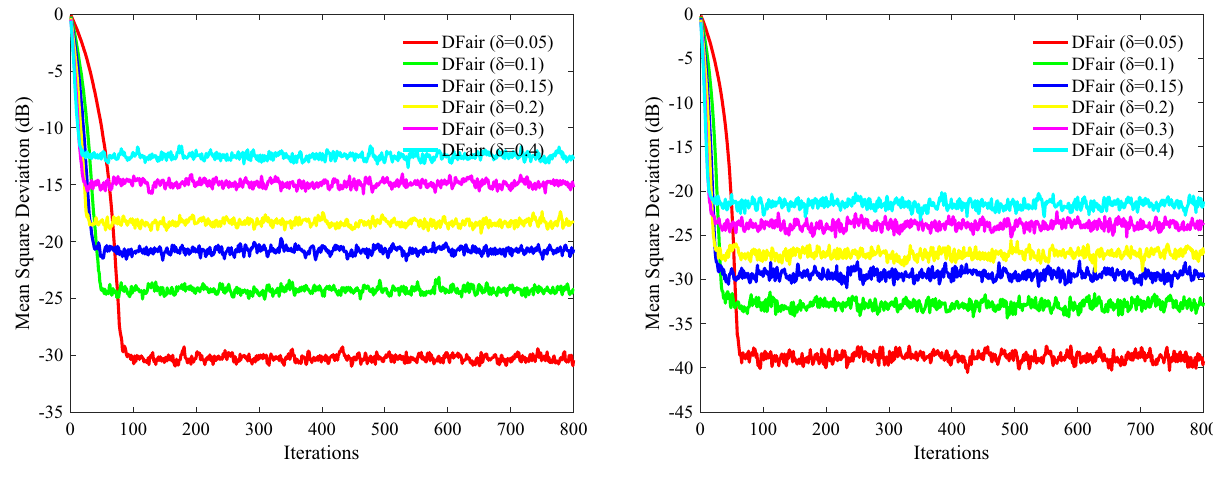
Figure 2. MSD curve with different δ of the DFair algorithm ( μ = 0.4) when network topology and neighbors to be decided by probability (probability = 0.2): (Left) R xx , n = σ 2 x , n I M , Pr = 0.6, and σ 2 f = 0.5 . (Right) R